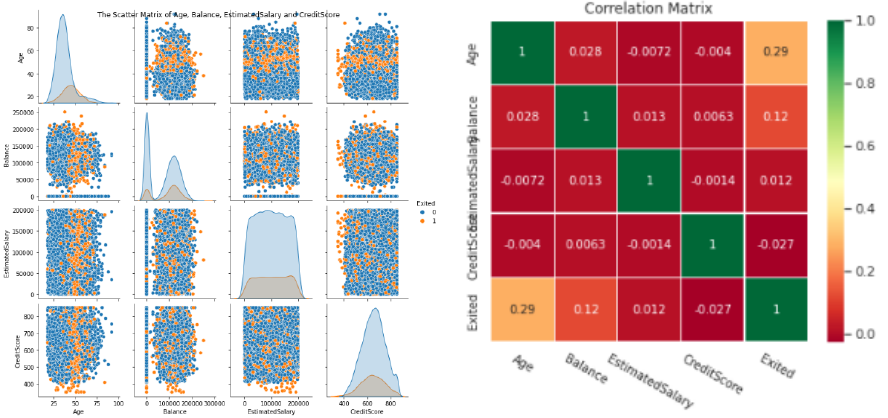
Figure 3. Correlation matrices between numerical variables and target variables.